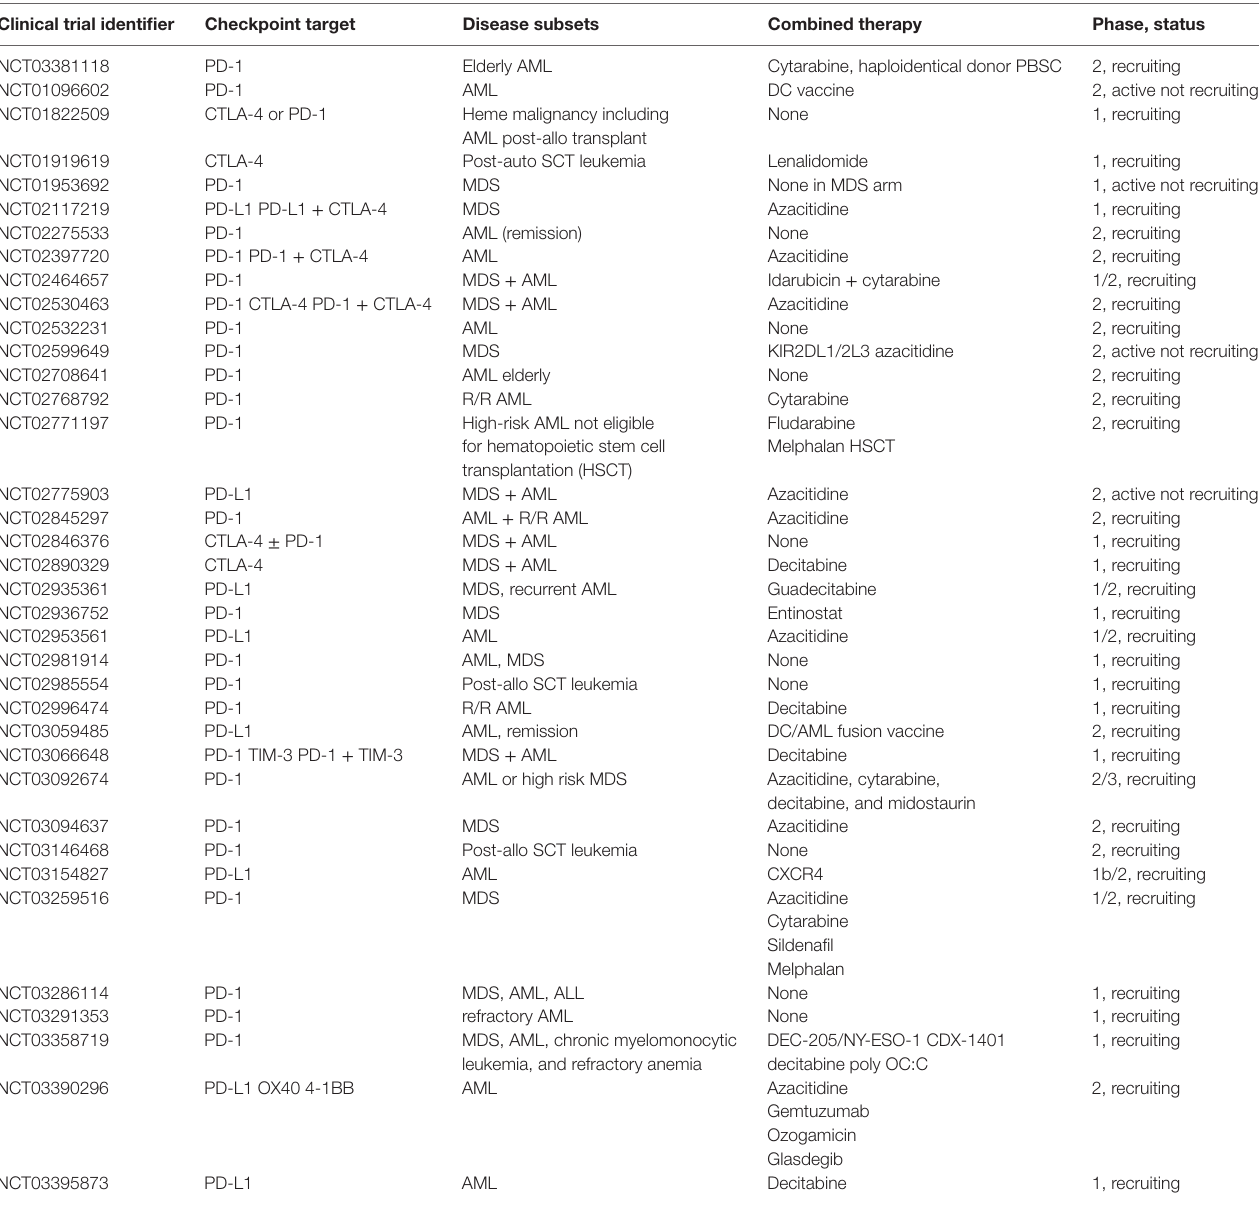
TABLe 1 | Ongoing clinical trials using checkpoint inhibitors in myelodysplastic syndrome (MDS) and acute myeloid leukemia (AML). Clinical trial